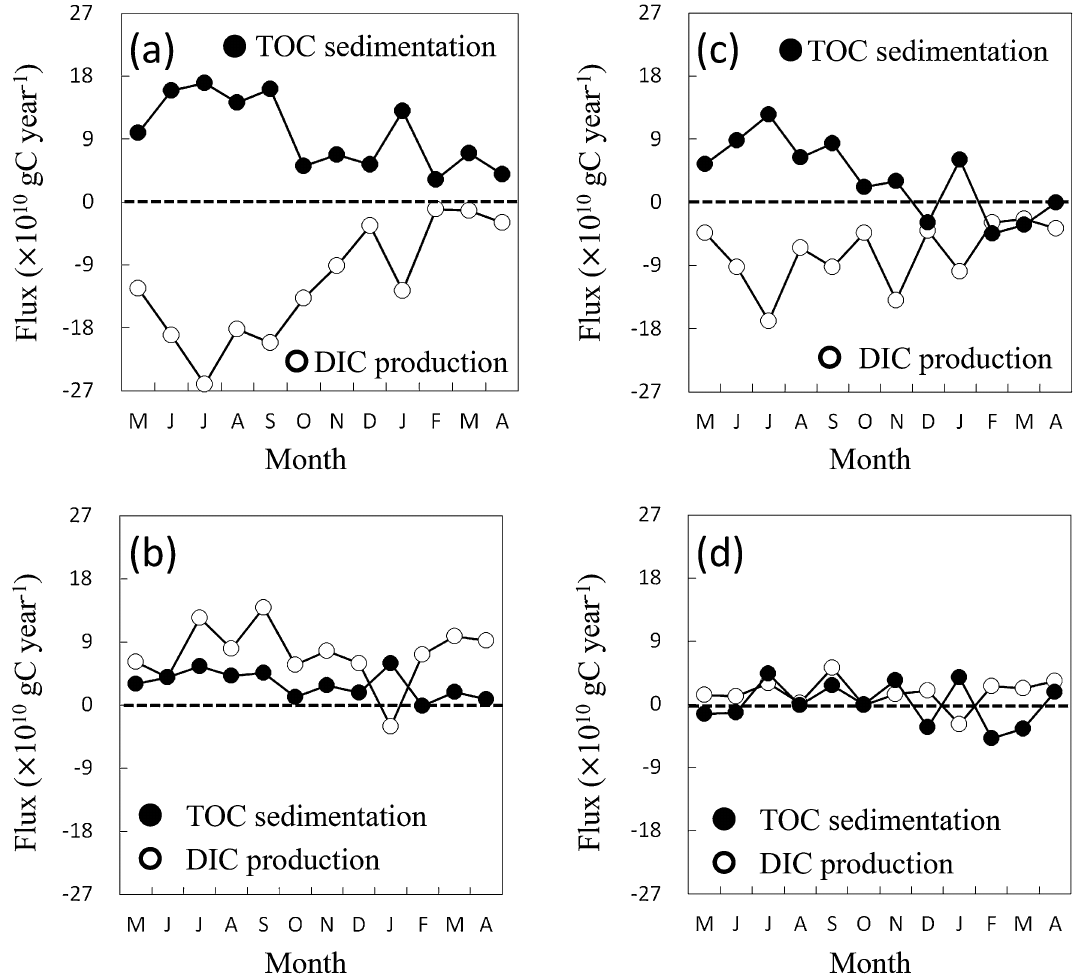
Figure 3. Monthly flux of total organic carbon (TOC) sedimentation rate (black circle) and dissolved inorganic carbon (DIC) production rate (white circle) in each box from May 2011 to April 2012: ( a ) Box 1, ( b ) Box 2, ( c ) Box 3, and ( d ) Box 4. Positive TOC sedimentation rate indicates TOC sedimentation from surface to bottom water or from bottom water to sediment. Negative TOC sedimentation rate indicates resuspension of TOC. Positive DIC production rate indicates DIC production in box, and negative value indicates DIC uptake in